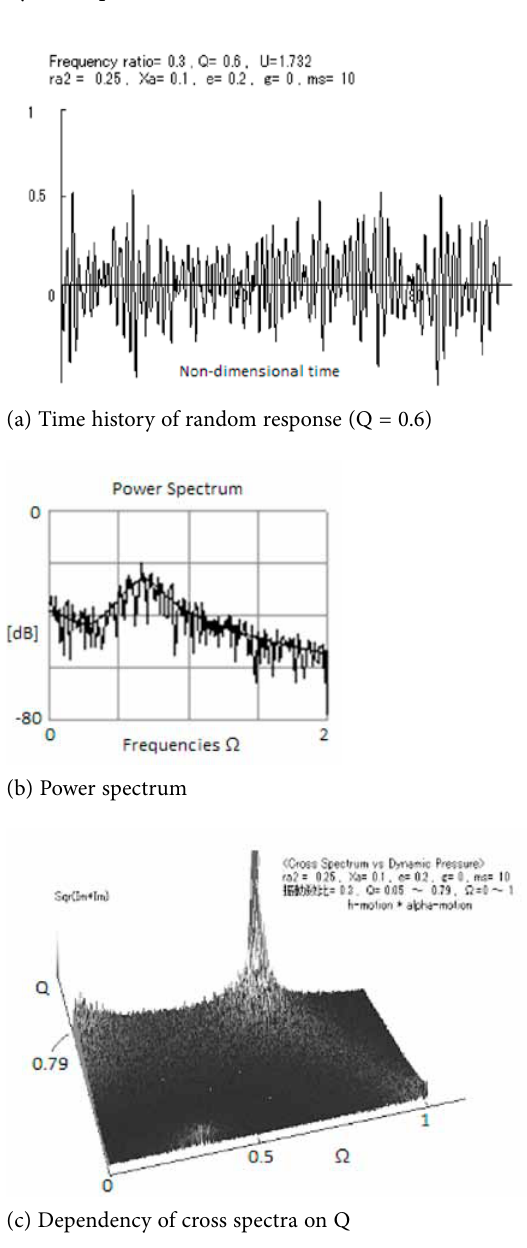
Fig. 6. Wavelet flutter prediction from the simulated